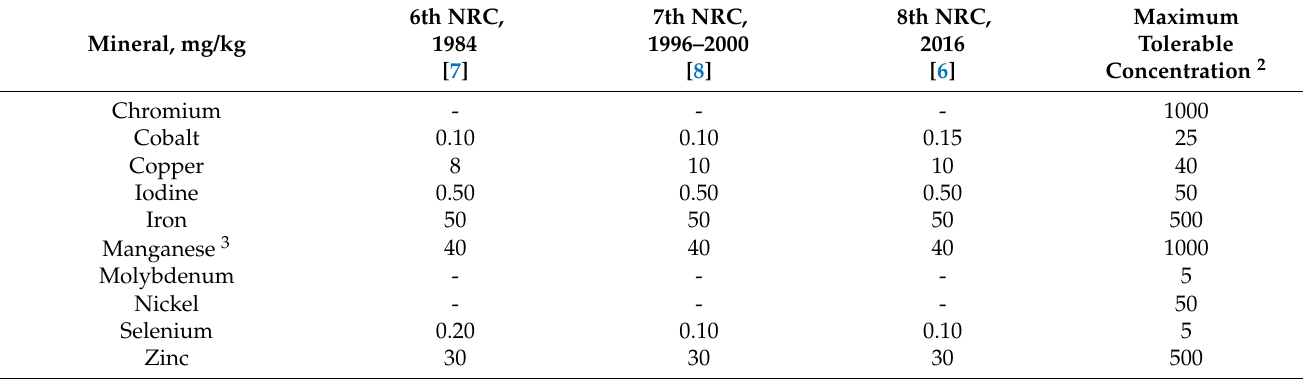
Table 1. Changes in trace mineral requirements of beef cattle from 1984 to 2016 1